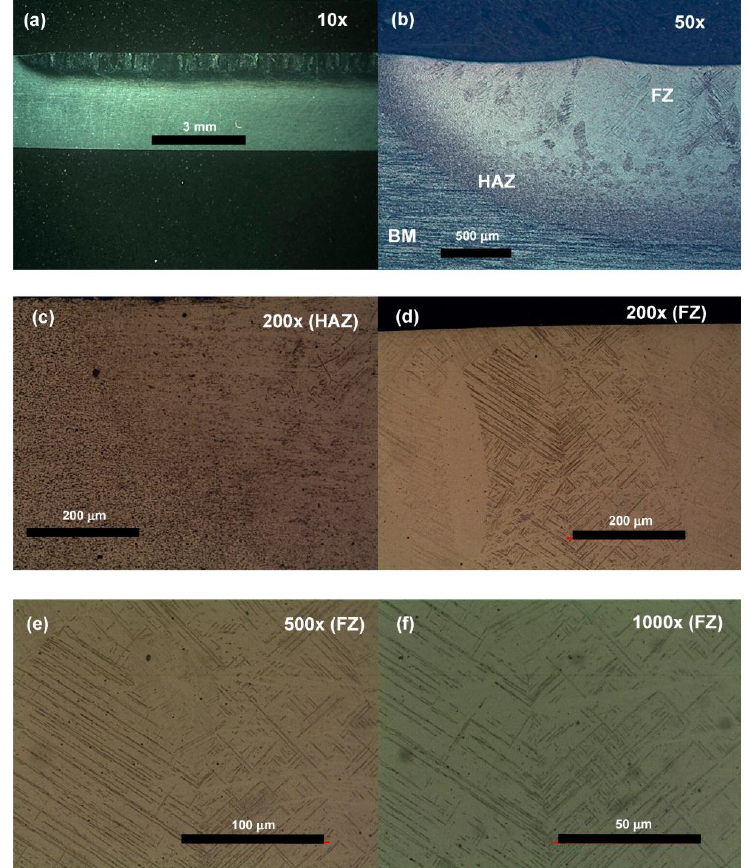
Figure 5. Metallographic images of the indicated zones of the Ti 6 Al 4 V-LR samples, at the indicated magnifications: ( a ) 10 × , ( b ) 50 × , ( c ) 200 × (HAZ), ( d ) 200 × (FZ), ( e ) 500 × (FZ), ( f ) 1000 × Table 2. Mean and standard deviation of Vickers microhardness (HV 2) of Ti 6 Al 4 V-BM and Ti 6 Al 4 V- LR.